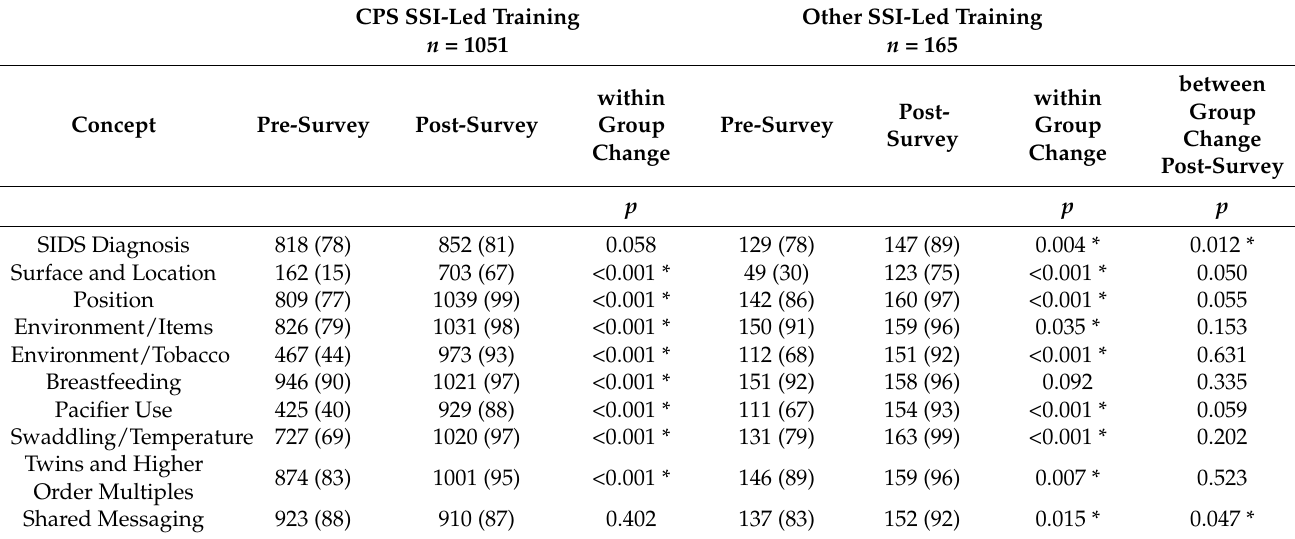
Table 3. Professionals reporting only safe/correct responses for knowledge of American Academy of Pediatrics safe sleep